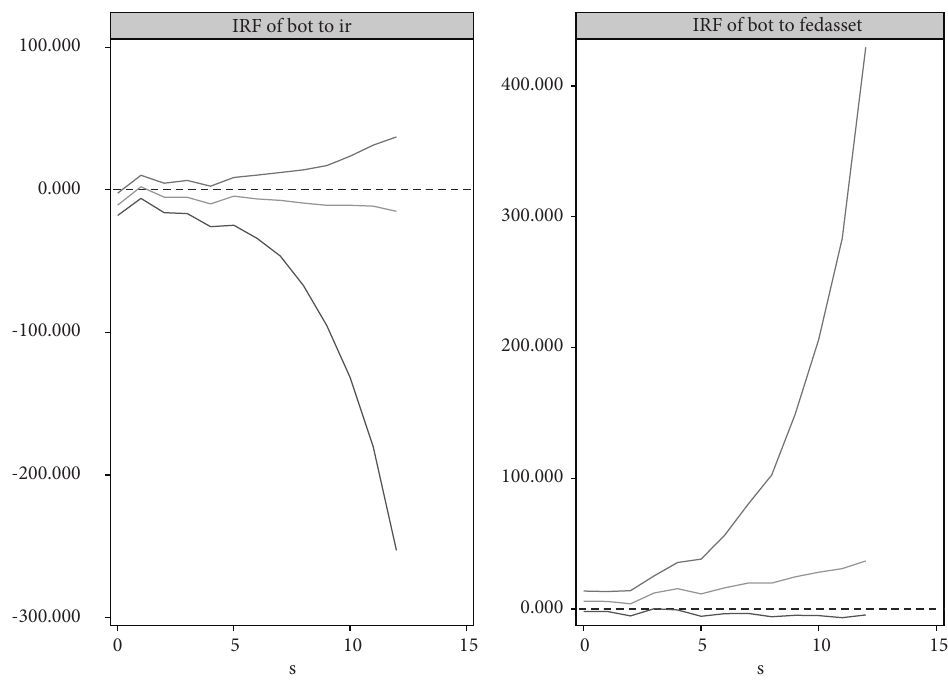
Figure 3: Impulse responses of BOT to U.S. monetary policy shock in BRICS